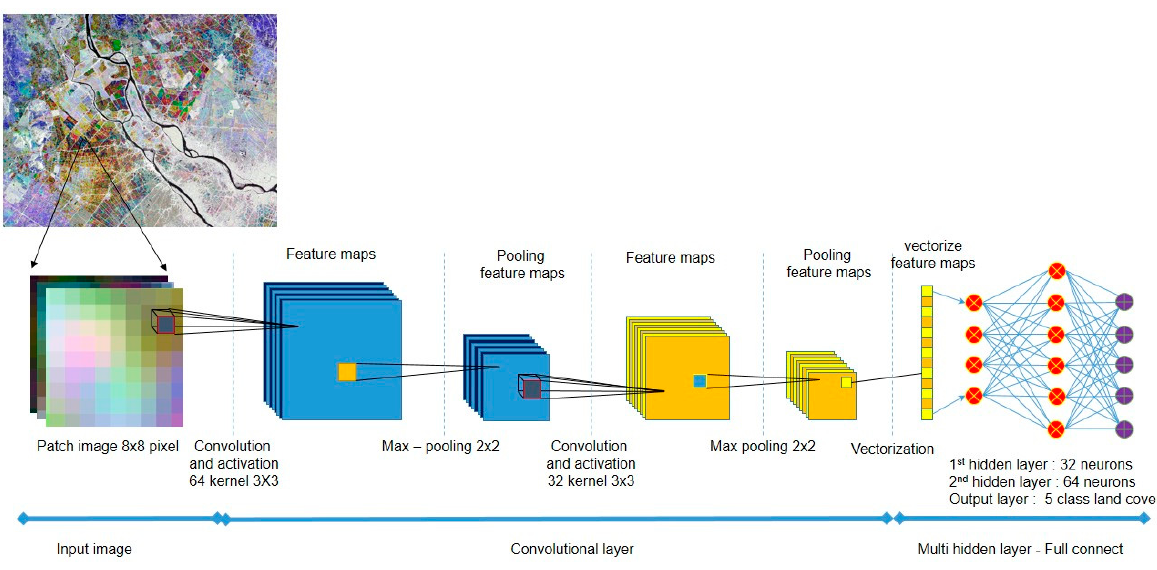
Figure 4. Generalized CNN classifier with the 2D-CNN architecture. Multi-Layer Perceptron